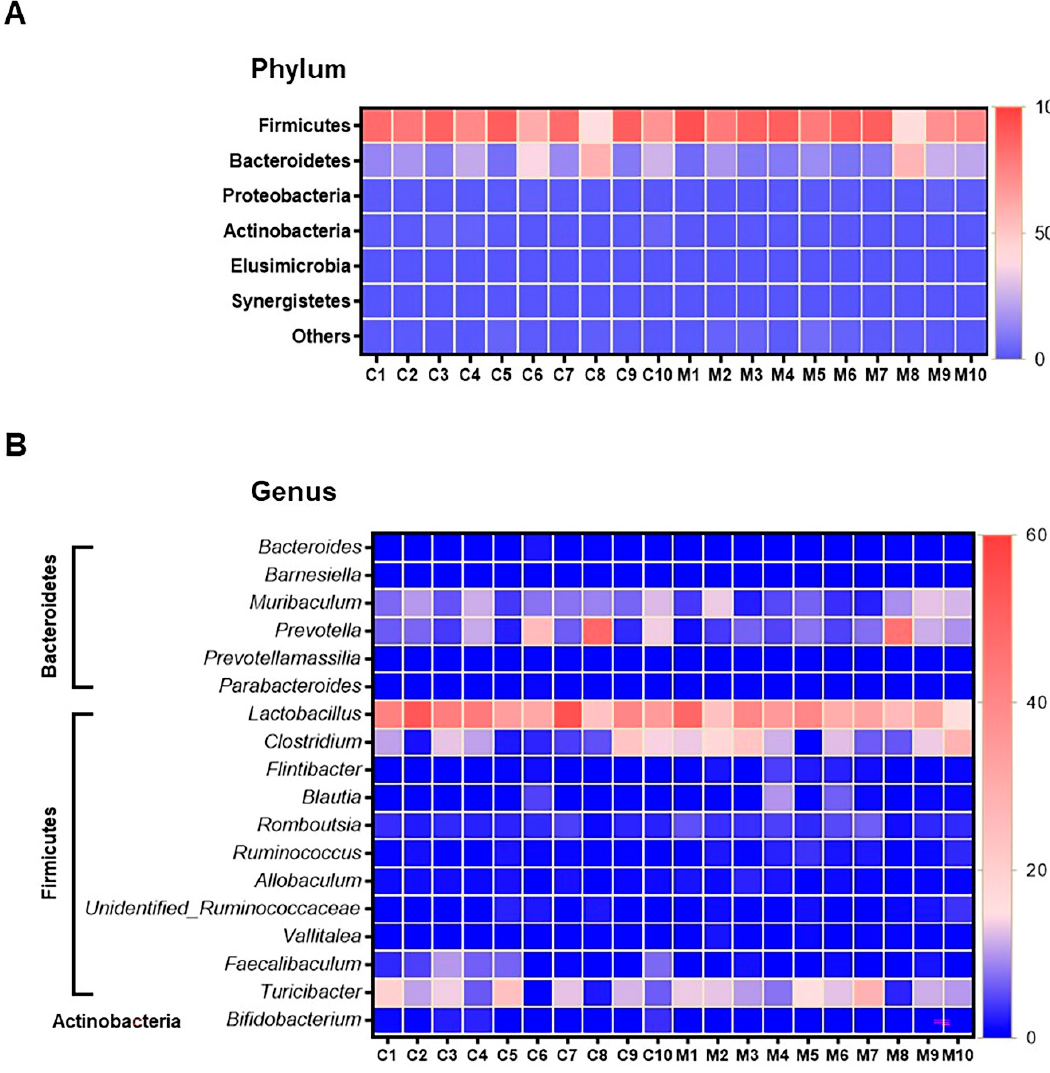
Figure 5. Heatmap of relative operational taxonomic unit (OTU) abundance at the phylum level ( A ), and genus level ( B ) from faeces samples of control ( n = 10) and the MSG group ( n = 10). The colour key corresponds to percent relative abundance of the gut microbiota in OTU at each expression level.